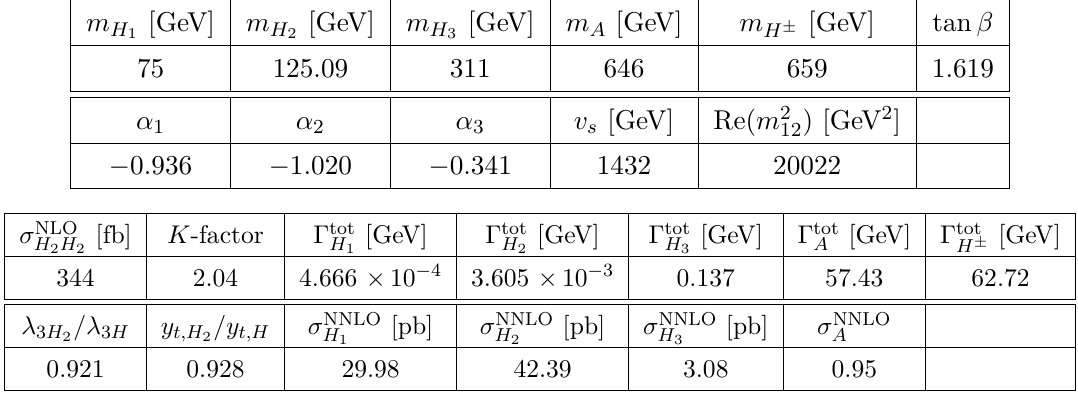
Table 14 . BP7 Upper: N2HDM-I input parameters. Lower: additional double and single Higgs production related